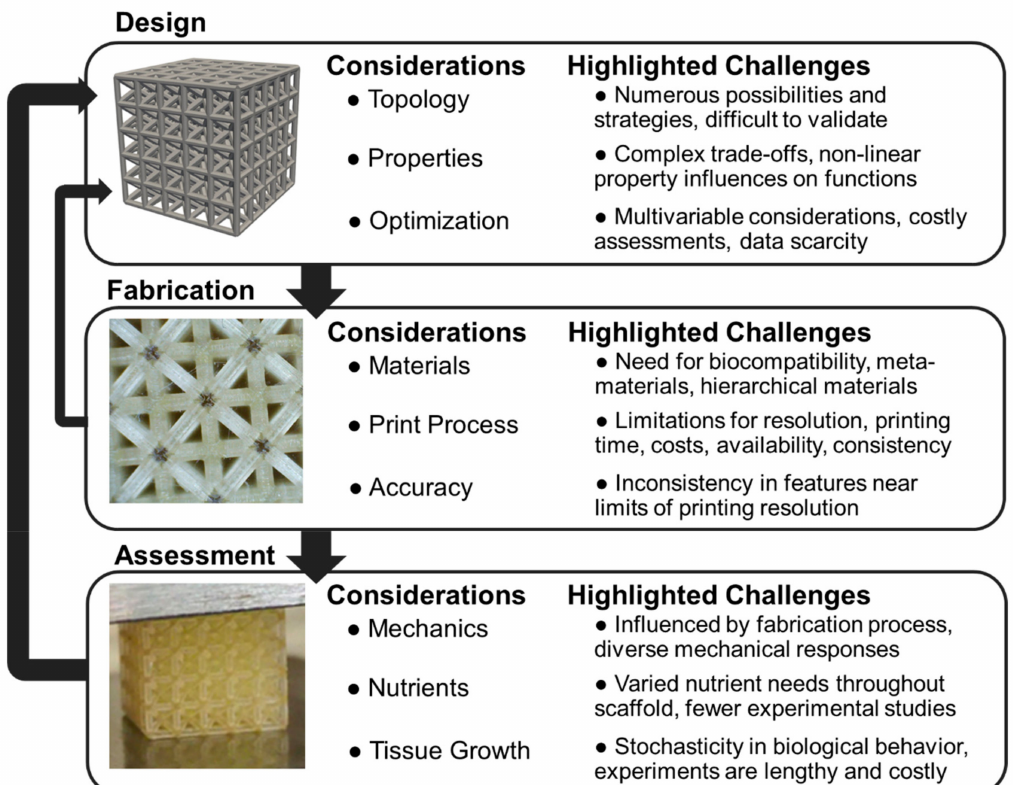
Figure 7. Summarized considerations and challenges for integrated design, fabrication, and assessment of tissue sca ff olds for clinical